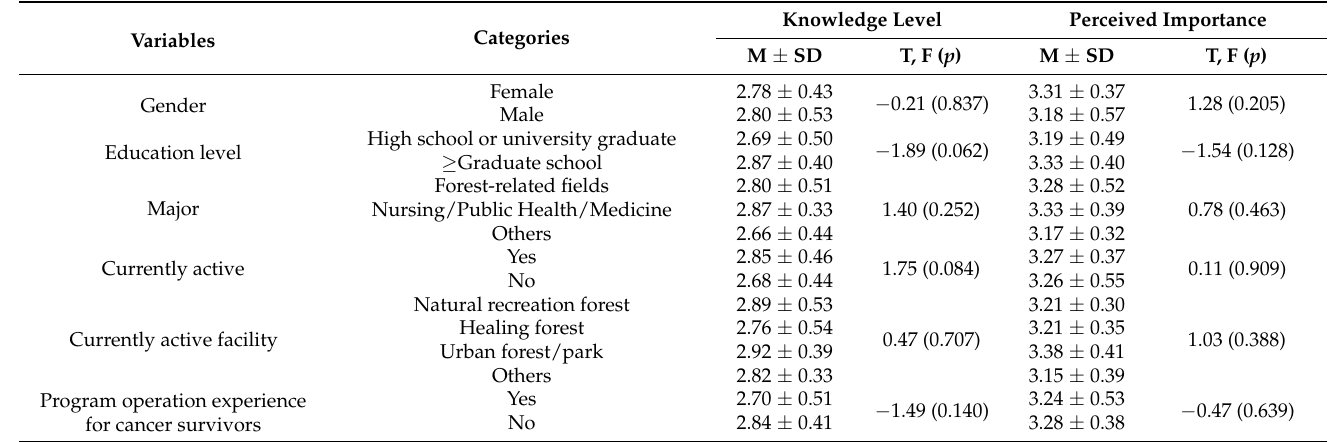
Table 2. Differences in knowledge level and perceived importance of forest healing programs for cancer survivors according to participants’ characteristics and cancer survivor program operation